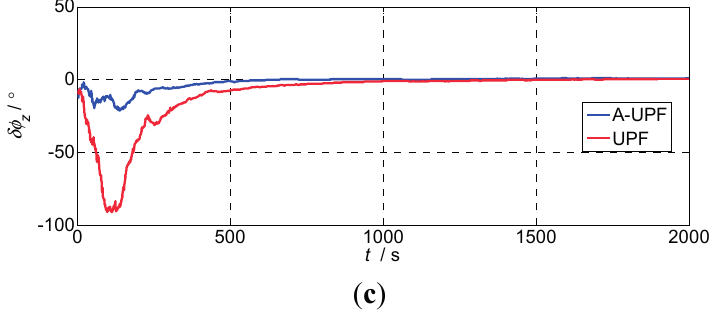
Figure 2. The alignment errors of large misalignment angles ( errors; ( b ) Roll errors; ( c ) Heading errors.